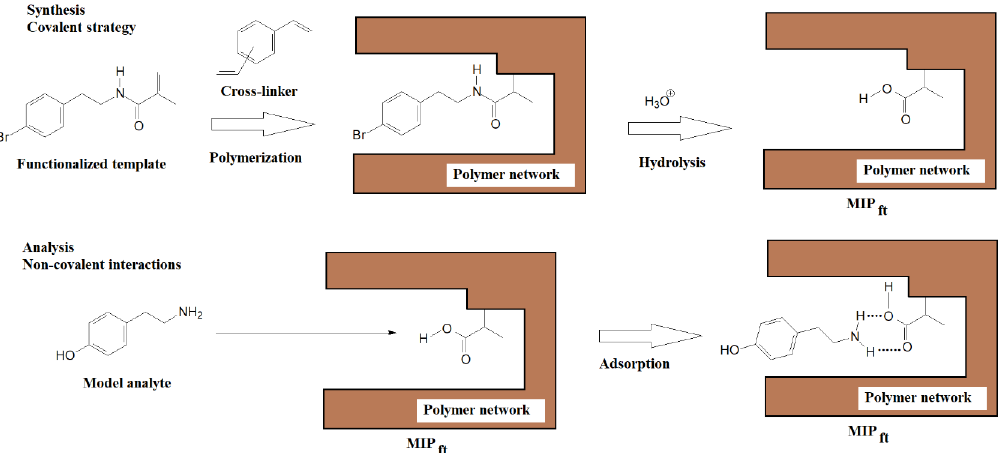
Figure 1. Schematic idea of the synthesis, employing a covalent strategy for the imprinting process and an adsorption process on the resultant imprinted polymer that is based on non-covalent interactions of the target analytes.